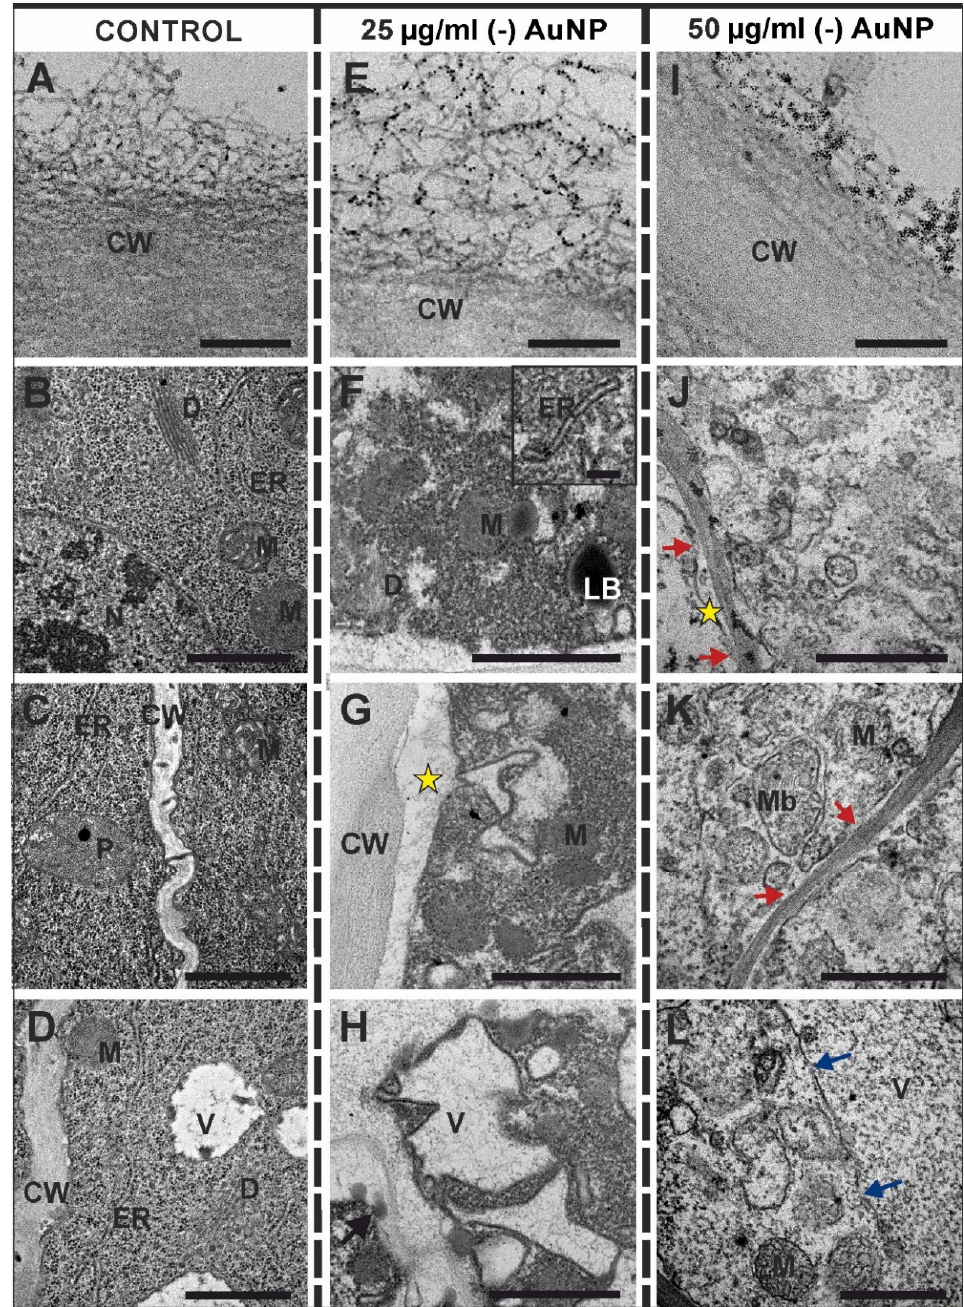
Figure 5. The ultrastructure of the rhizodermal cells from the control ( A – E ), the barley roots that were treated with 25 μ g/mL ( ‐ ) AuNP ( E – H ) or 50 μ g/mL ( ‐ ) AuNP ( I – L ). The outer periclinal rhizodermal cell wall of the control ( A ), the barley roots that were treated with 25 μ g/mL ( ‐ ) AuNP ( E ) or 50 μ g/mL ( ‐ ) AuNP ( I ). The electron ‐ dense dots in the control root are the result of overlapping fibrils running in dif ‐ ferent directions ( A ). In the treated roots, the AuNP were retained in the fibrous of the cell wall ( E , I ). Black arrow indicates electron ‐ dense spots in the cell wall; red arrows indicate a cell membrane rupture; blue arrows indicate a tonoplast rupture; yellow asterisks indicate the periplasmic space; CW—cell wall; D—dictyosome; ER—endoplasmic reticulum; LB—lipid body; M—mitochondrion; Mb—multivesicular body; N—nucleus; NU—nucleolus; P—plastid; Pb—paramural body; V—vacuole; Ve—vesicles. Scale bars: ( A , E , I ; F Inset ) = 200 nm; ( B – D , F – H , J – L ) = 1 μ m.